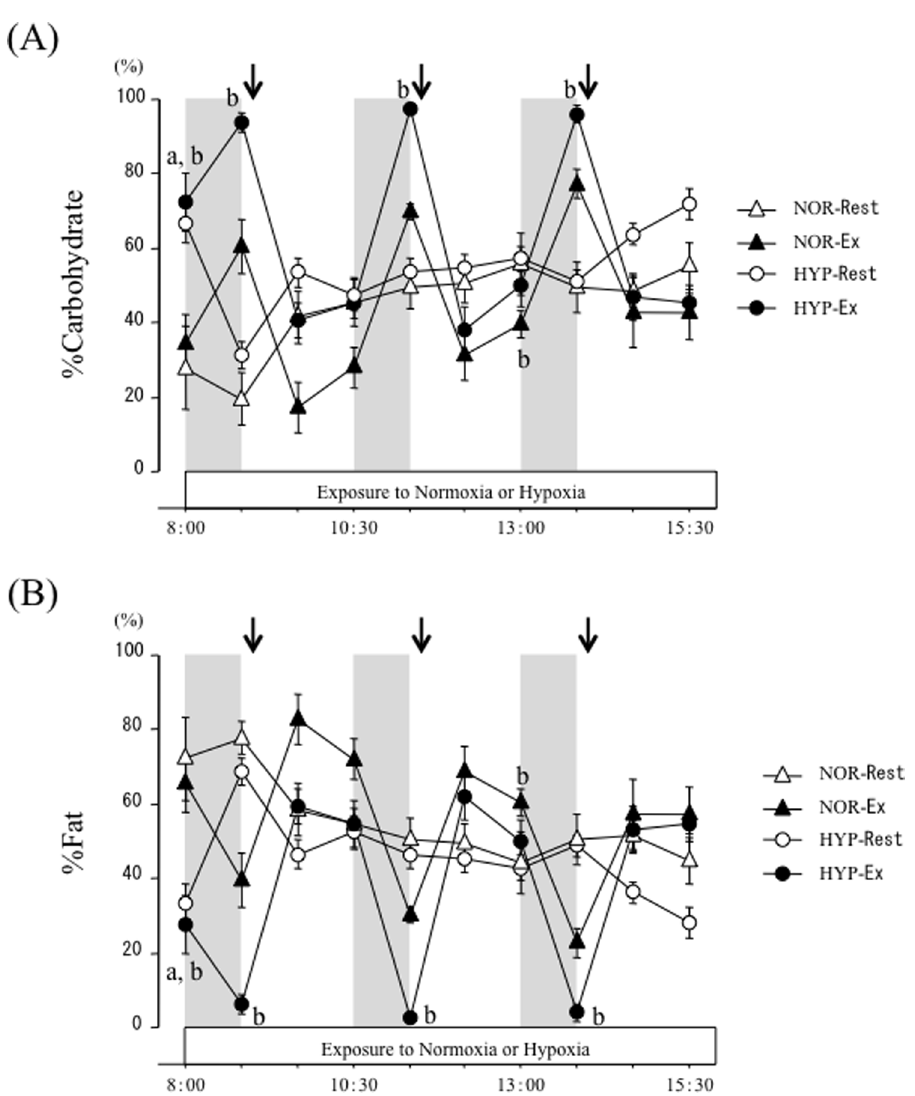
Figure 5. Relative contribution of carbohydrate (A) and fat (B) oxidation over 7.5 h. Each period of exercise is indicated by the shaded boxes. The arrow indicates the time of meal consumption. a; P , 0.05, NOR-Rest vs. HYP-Rest. b; P , 0.05, NOR-Ex vs.